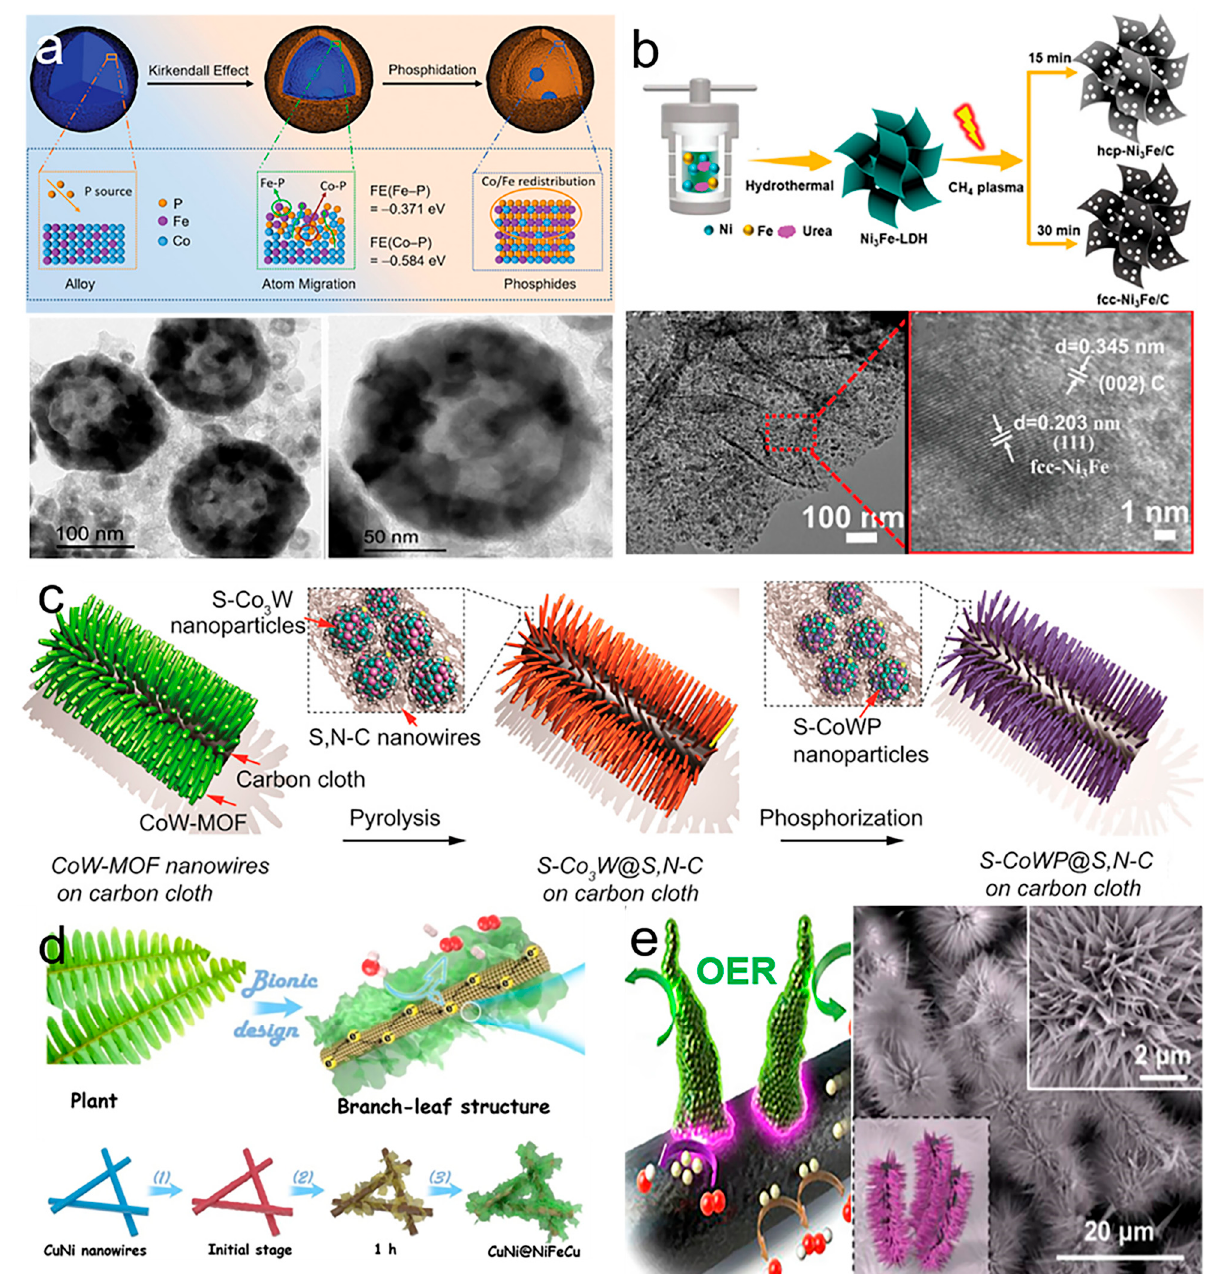
Figure 8. ( a ) Schematic illustration of atom migration during the phosphorization process and TEM images of Co 7 Fe 3 phosphides. Reproduced with permission of [70], copyright 2021 John Wiley and